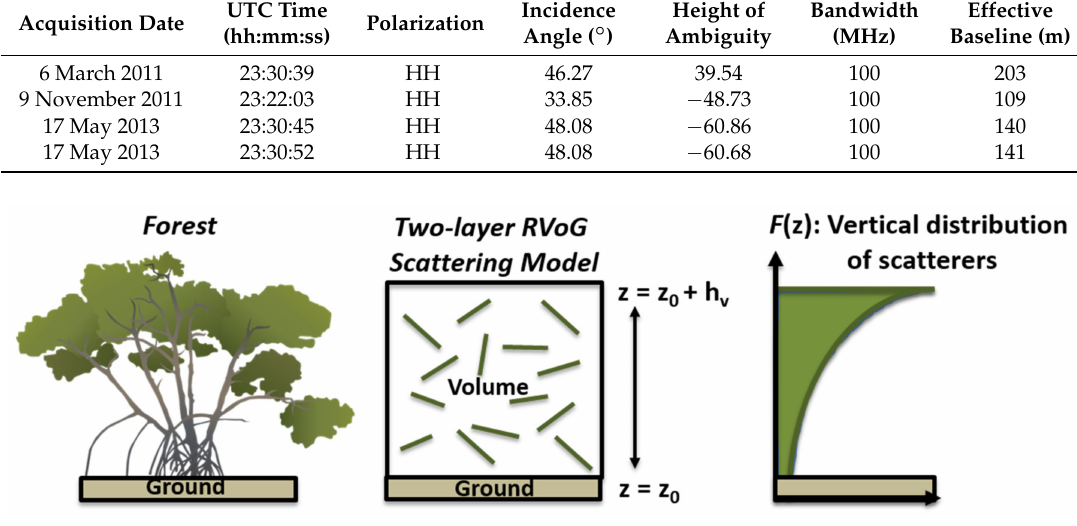
Figure 5. Schematic illustration of the Random Volume over Ground (RVoG) model modified after Treuhaft et al.